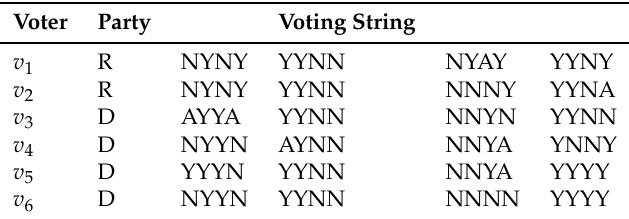
Table 1. The voting entries of the first six voters in the 1984 US congress dataset.